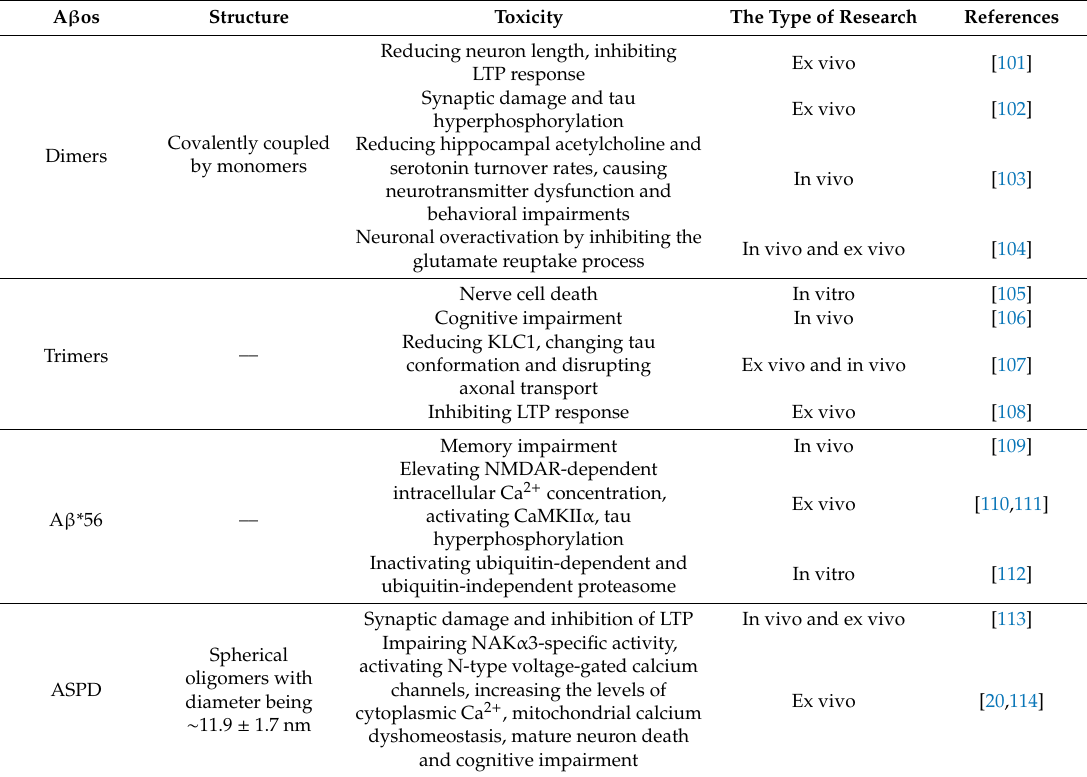
Table 1. The characteristics and toxicity of several A β